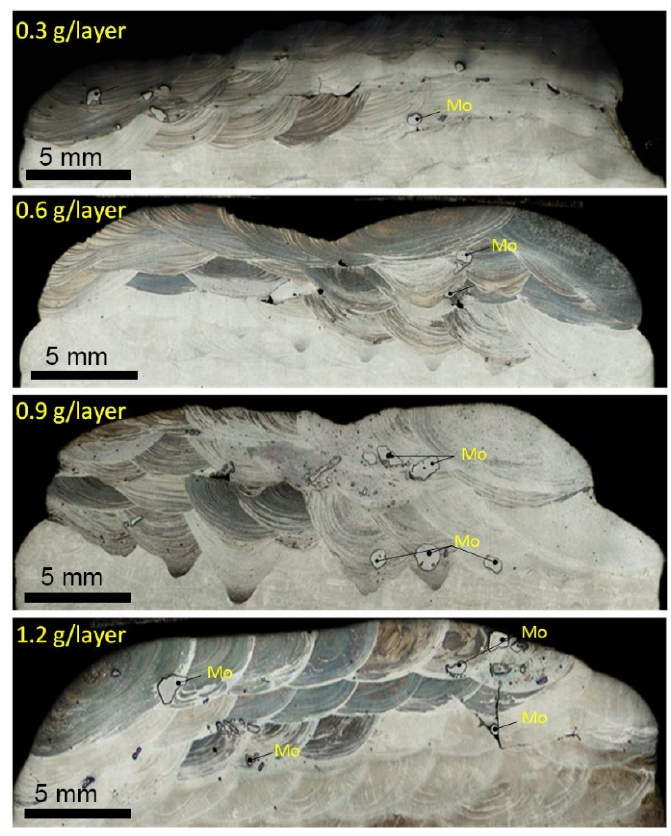
Figure 2. Optical cross section images of AA5154/Mo track zones.